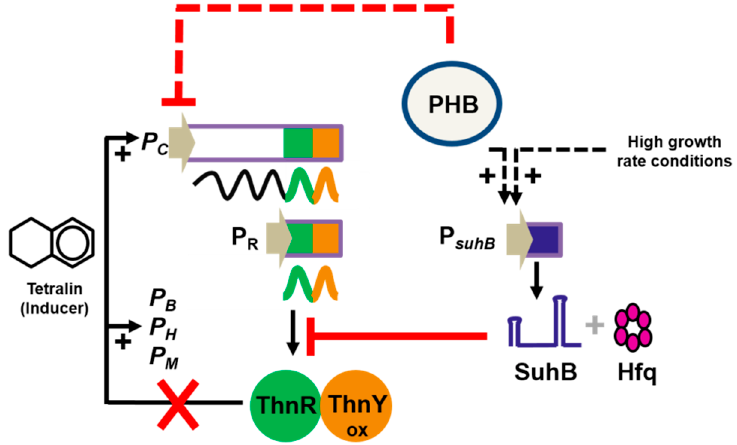
Figure 4. Elements involved in carbon catabolite repression in TFA. High growth rate conditions like growth on a preferential carbon source like β HB and the presence of PHB granules have a positive effect on suhB transcription. This sRNA, together with Hfq, affects negatively ThnR translation in those conditions impeding induction of thn promoters ( P C , P B , P H and P M ) in the presence of tetralin. The presence of PHB granules themselves have a negative effect on thn induction. Doted and solid lines represent unknown and known mechanism, respectively.